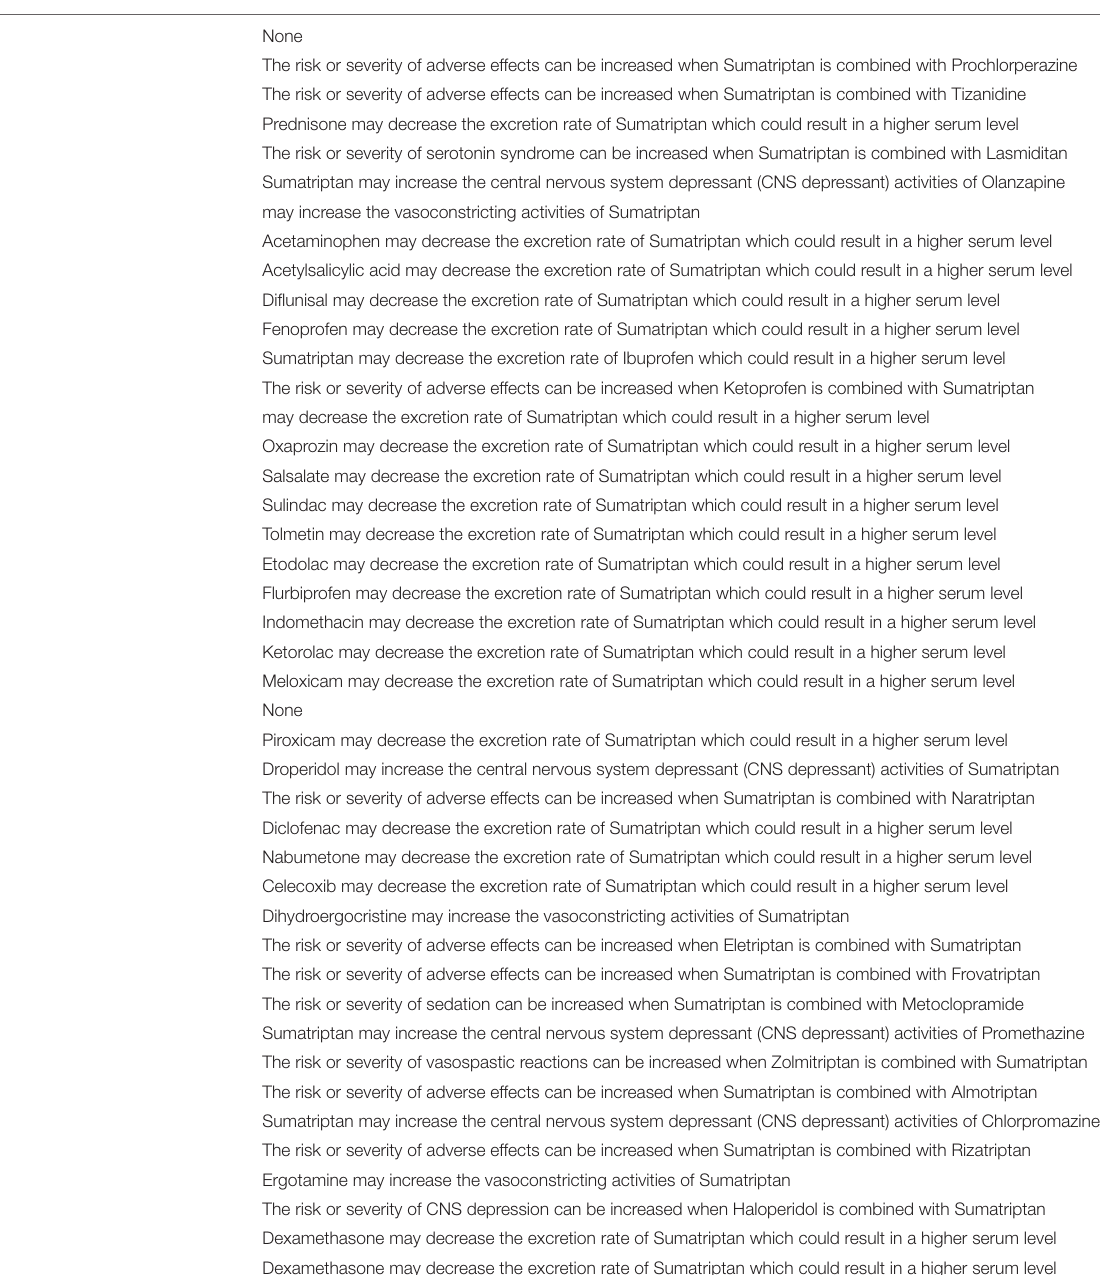
TABLE 3 | Sumatriptan